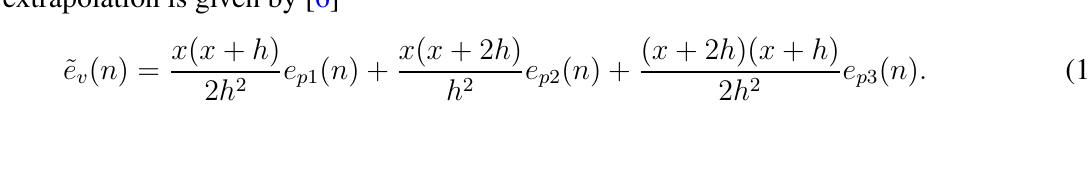
Figure 5. Diagram of (a) two microphone linear forward difference extrapolation; and (b) three microphone quadratic forward difference extrapolation. The black curved line repre- sents the actual pressure field and the dashed line represents the pressure estimate.